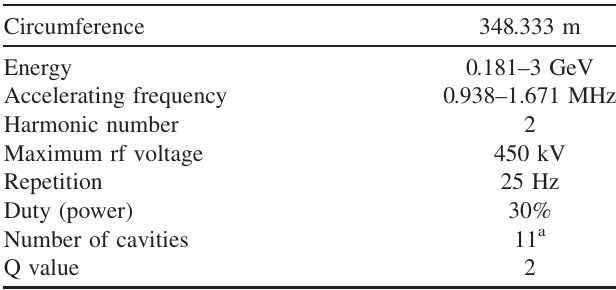
TABLE I. Parameters of the J-PARC RCS and its rf system.